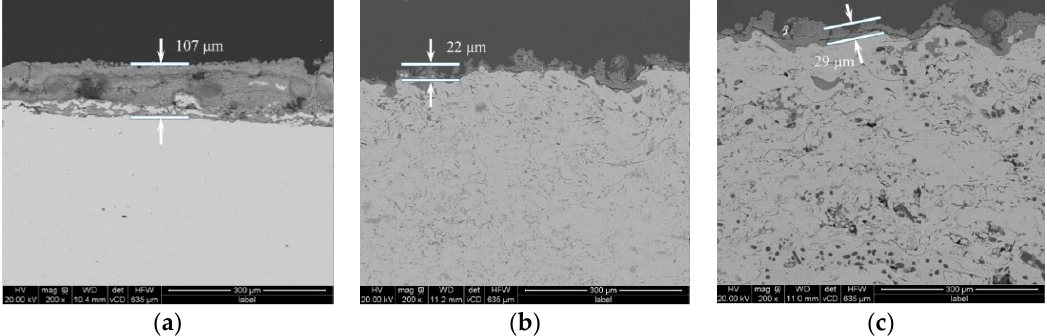
Figure 5. Cross-sectional morphology of the coatings after the corrosion testing showing the corrosion occurred on their top layer; SEM images of the cross-sections of ( a ) mild steel substrate, ( b ) Al coating, and ( c ) Al-CF coating subjected to a neutral salt spray test for 720 h.